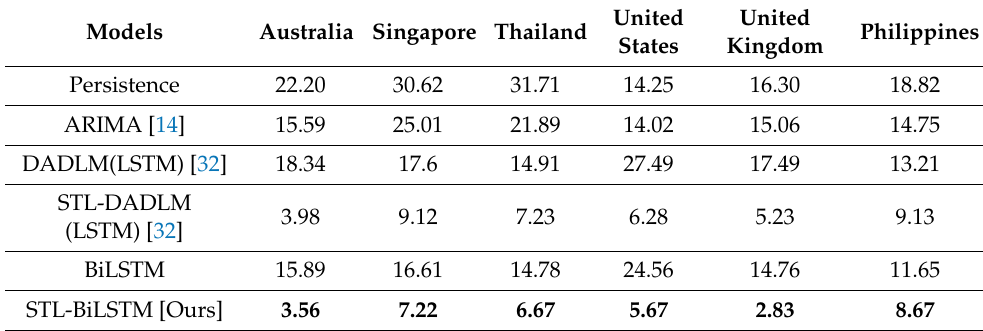
Table 5. MAPE comparison for selected forecasting methods for six source countries.